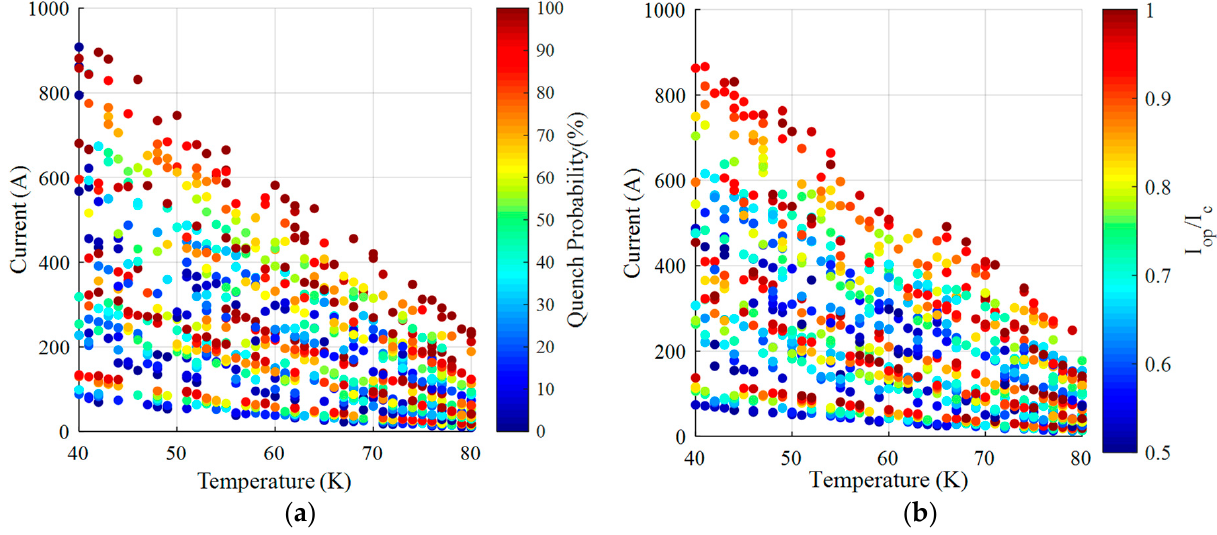
Figure 10. Current-temperature distribution of test points. ( a ) Based on quench probability. ( b ) Based on normalized operating current.